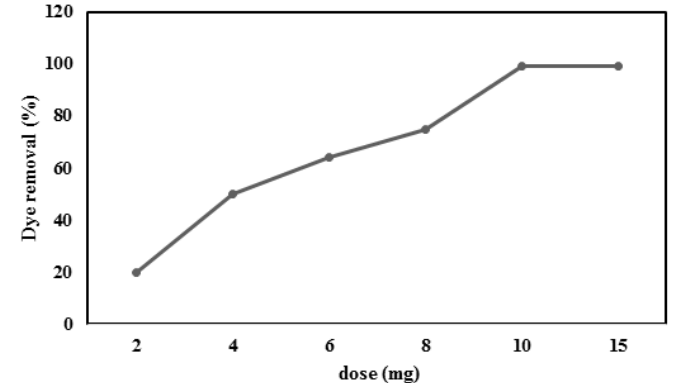
Fig. 4. Effect of the adsorbent dose on the adsorption of MG by nanobentonite. Conditions: initial dye concentration: 40 mgl −1 , pH: 6.0, T: 303 K, contact time: 100